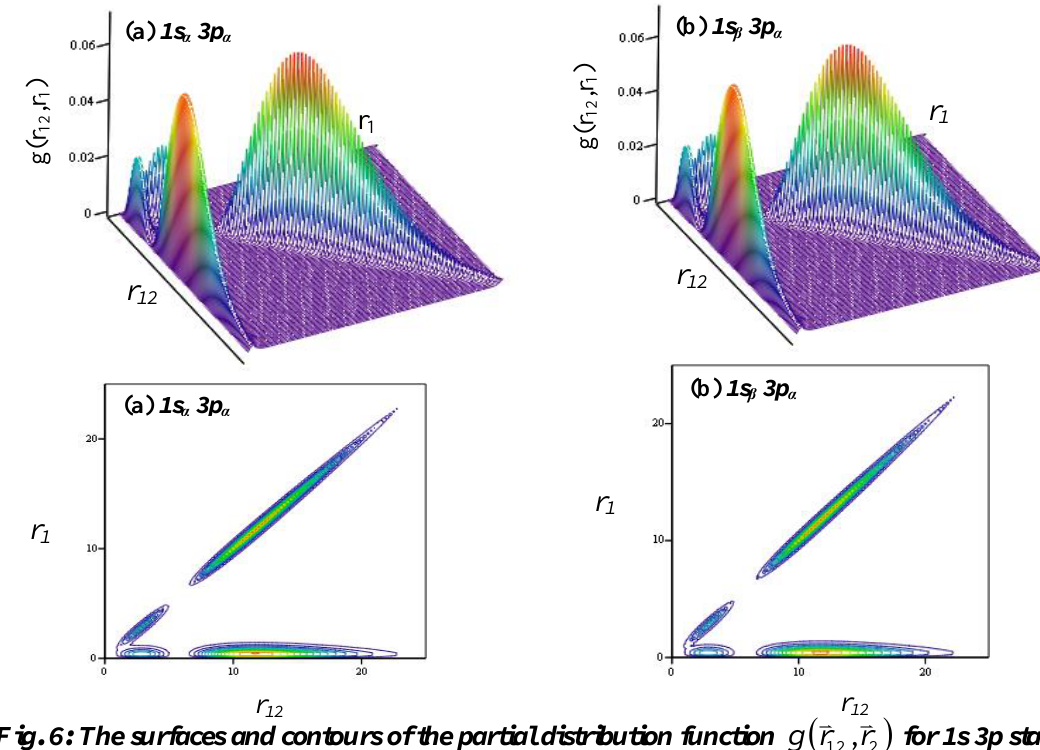
Fig. 6: The surfaces and contours of the partial distribution function  